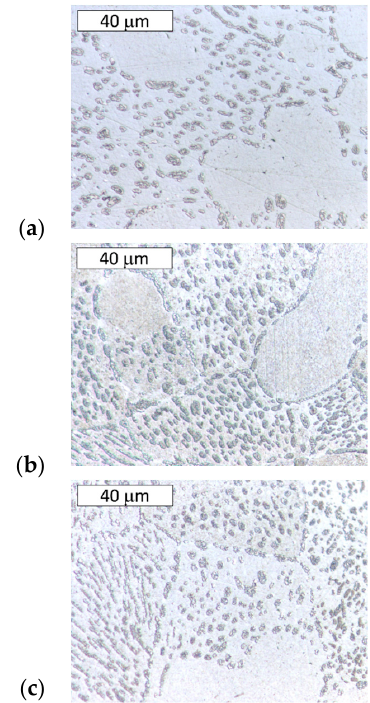
Figure 3. Microstructure of examined Zn-4Al alloy (as-delivered). Visible dendrites of η phase and a eutectic lamellar morphology ( α + η ). Etched with 10% NaCl solution. ( a ) Light Microscopy, ( b ) SEM.